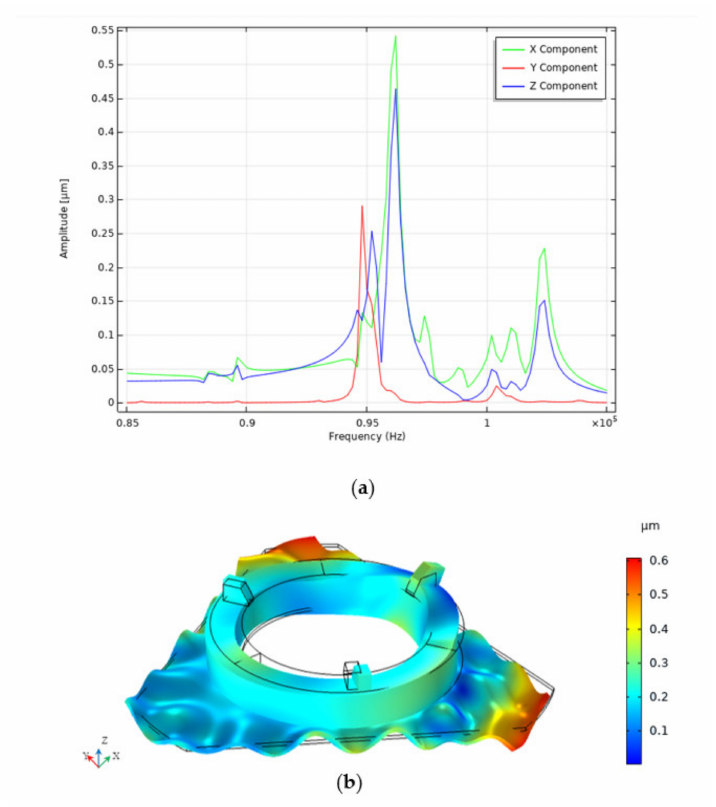
Figure 8. Results of numerical analysis of harmonic response with the triangle-shaped flange: ( a ) amplitude vs. frequency characteristic; ( b ) At resonance mode, 96.2 kHz . A comparison of the displacement amplitudes of the actuator with disc and triangle-shaped flanges are presented in Figure 9.